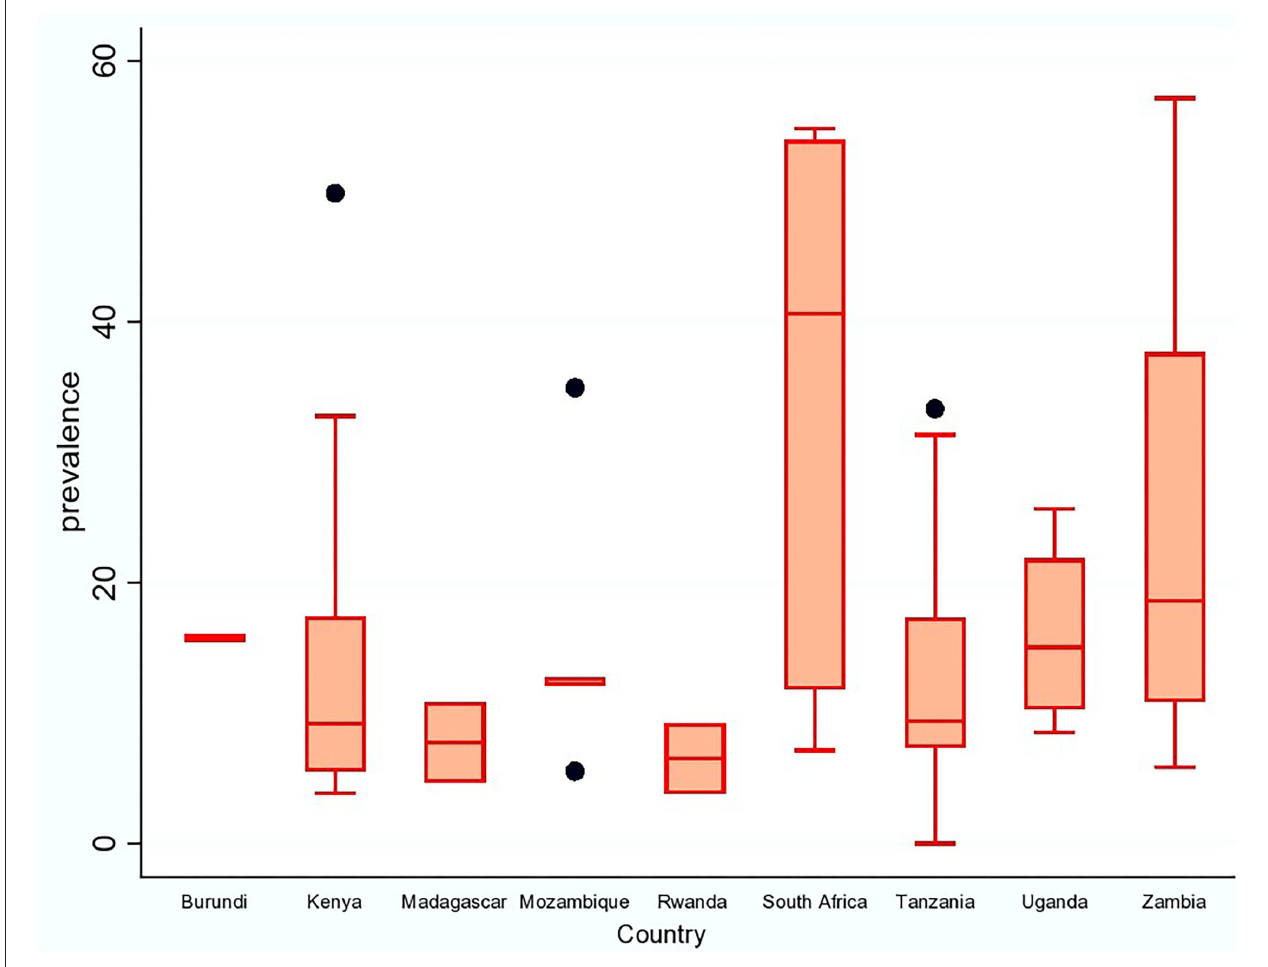
FIGURE 4 | Prevalence of porcine cysticercosis in countries within ESA